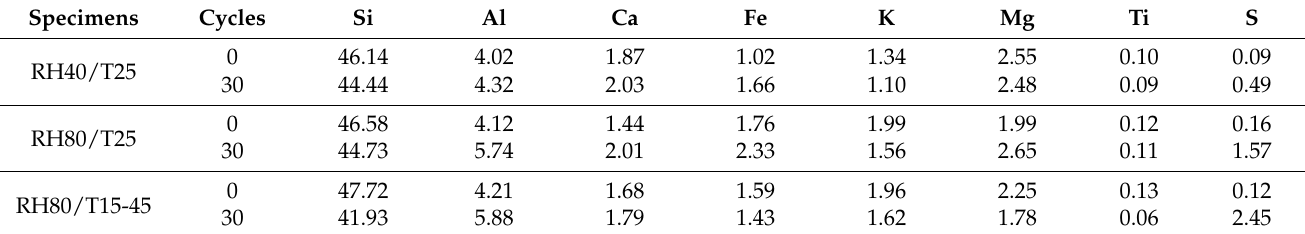
Table 6. Main element composition of specimens (in wt%).